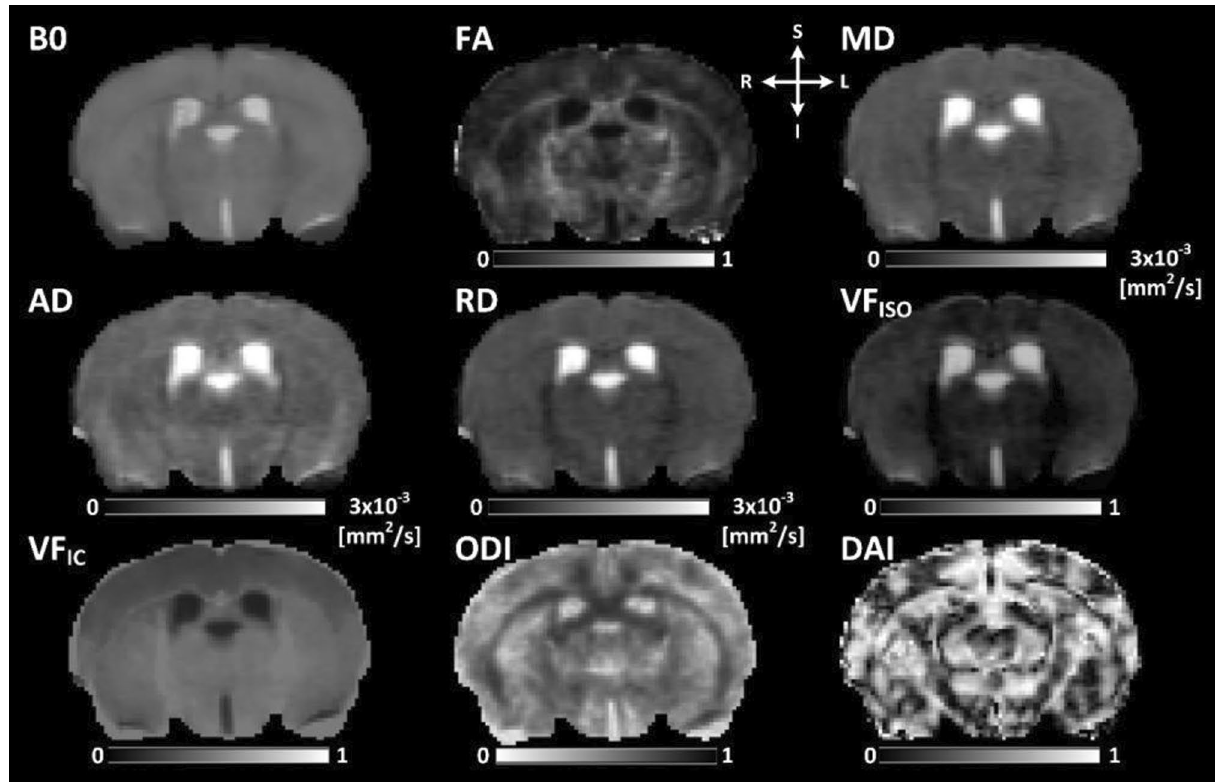
Figure 2. Microstructural parametric maps derived from DTI and NODDI using one of the PSE animals. L and R indicate anatomical orientation: left–right. S and I indicate anatomical orientation: superior–inferior. B0: non- diffusion weighted image, FA: fractional anisotropy, MD: mean diffusivity, AD: axial diffusivity and RD: radial diffusivity maps, were derived from DTI. VF ISO : volume fraction of isotropic water diffusivity, VF IC : intracellular volume fraction, ODI: orientation dispersion index and DAI: dispersion anisotropy index, were derived from the Bingham-NODDI